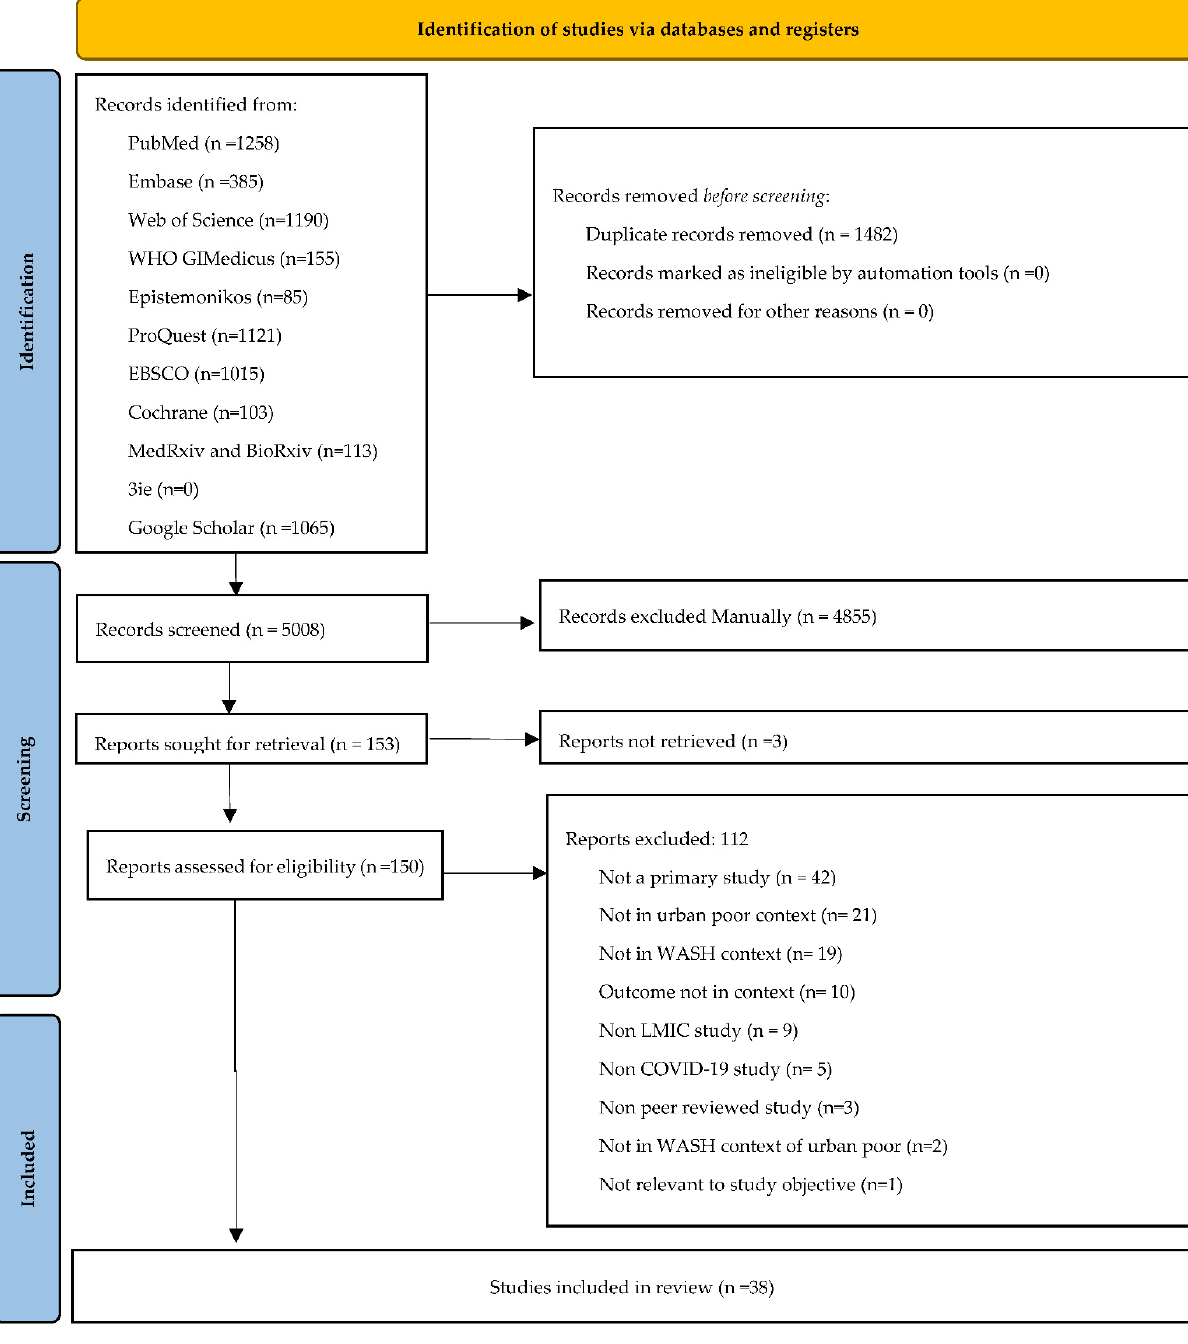
Figure 1. PRISMA flow